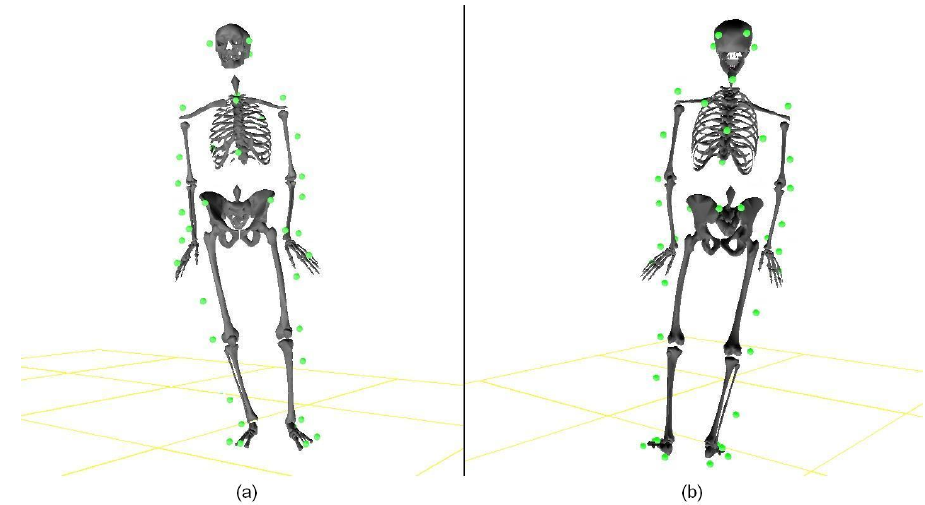
Figure 4. Placement of the 42 reflective markers for full ‐ body biomechanical modeling [19–21]: ( a ) a front view; ( b ) a back view. The asymmetric placement of the markers on limbs was used for distinguishing the left and right side of the body during motion capture.